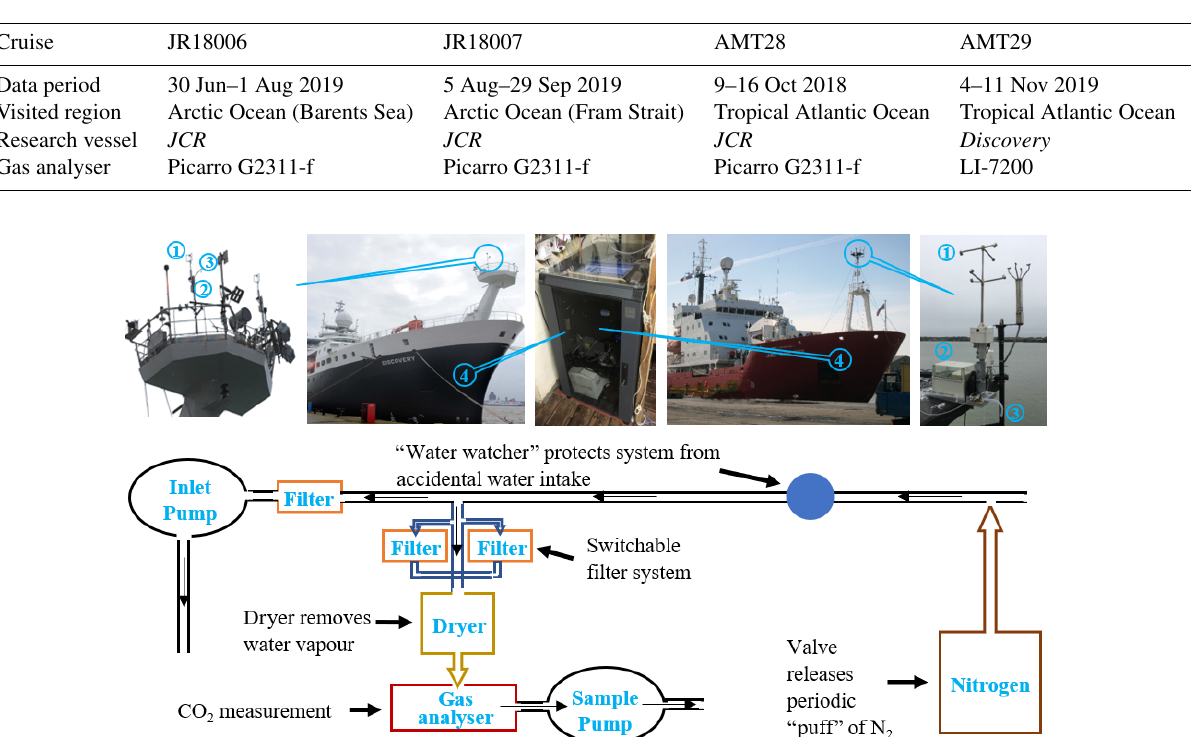
Figure 1. EC system (upper panel) and a diagram of the system setup (bottom panel). EC instruments: (1) sonic anemometer, (2) motion sensor, (3) air sample inlet for gas analyser, (4) data logger/gas analyser. Arctic and Atlantic data from 2018 were collected on the RRS James Clark Ross ( JCR ; upper right) using a Picarro G2311-f, and Atlantic data from 2019 were collected using a LI-7200 on the RRS Discovery (upper